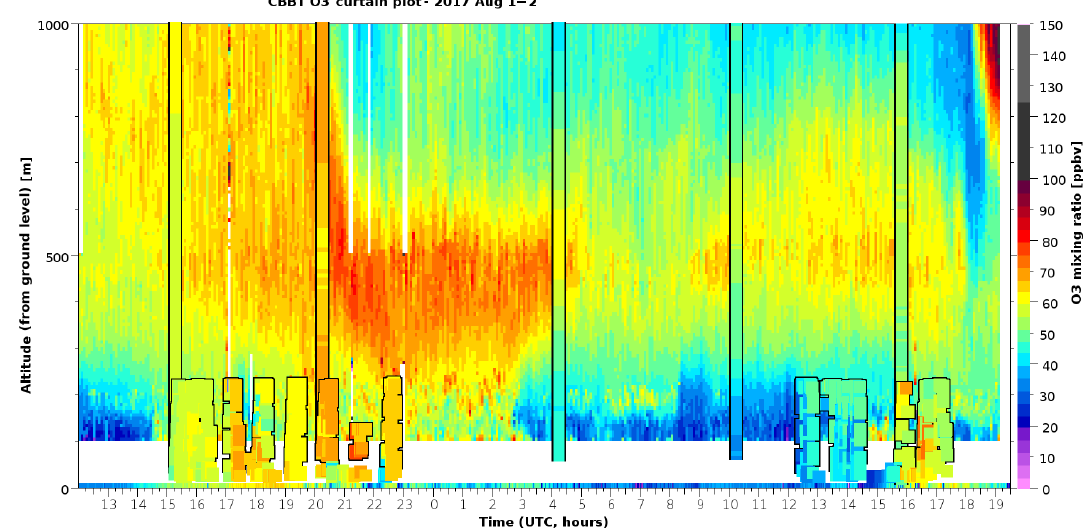
Figure 3. LMOL ozone 32h lidar curtain obtained 1–2 August, overlaid with five ozonesonde measurements and UAV in situ measurements